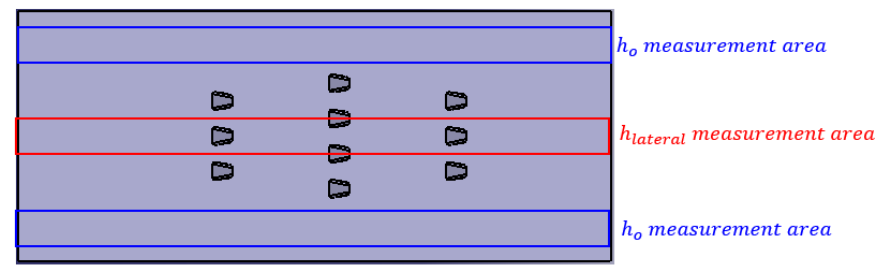
Figure 6. Schematic of measurement area.